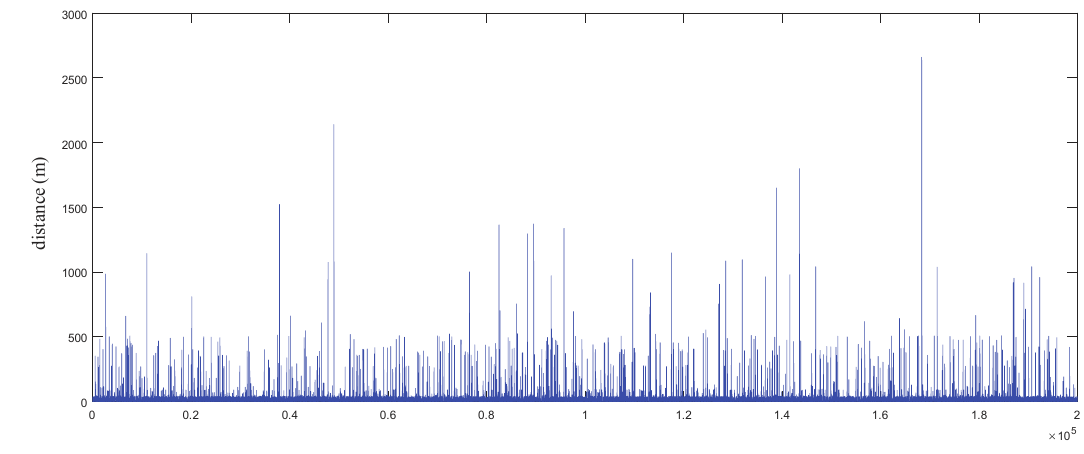
Figure 8. Moving Distance